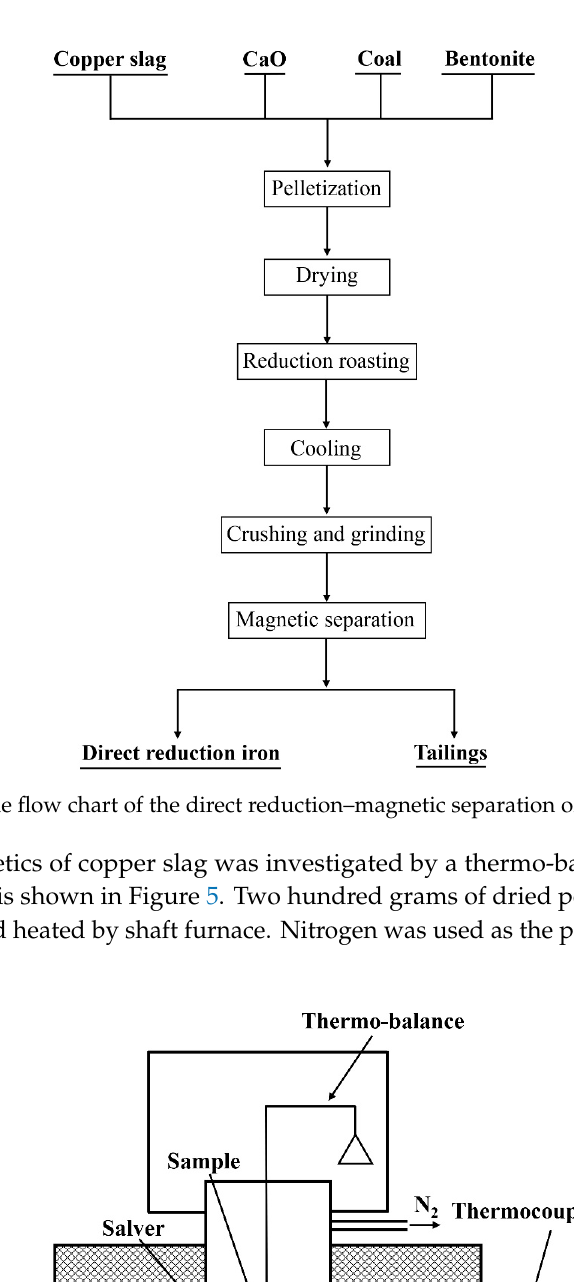
Figure 5. The diagram of the experimental equipment.